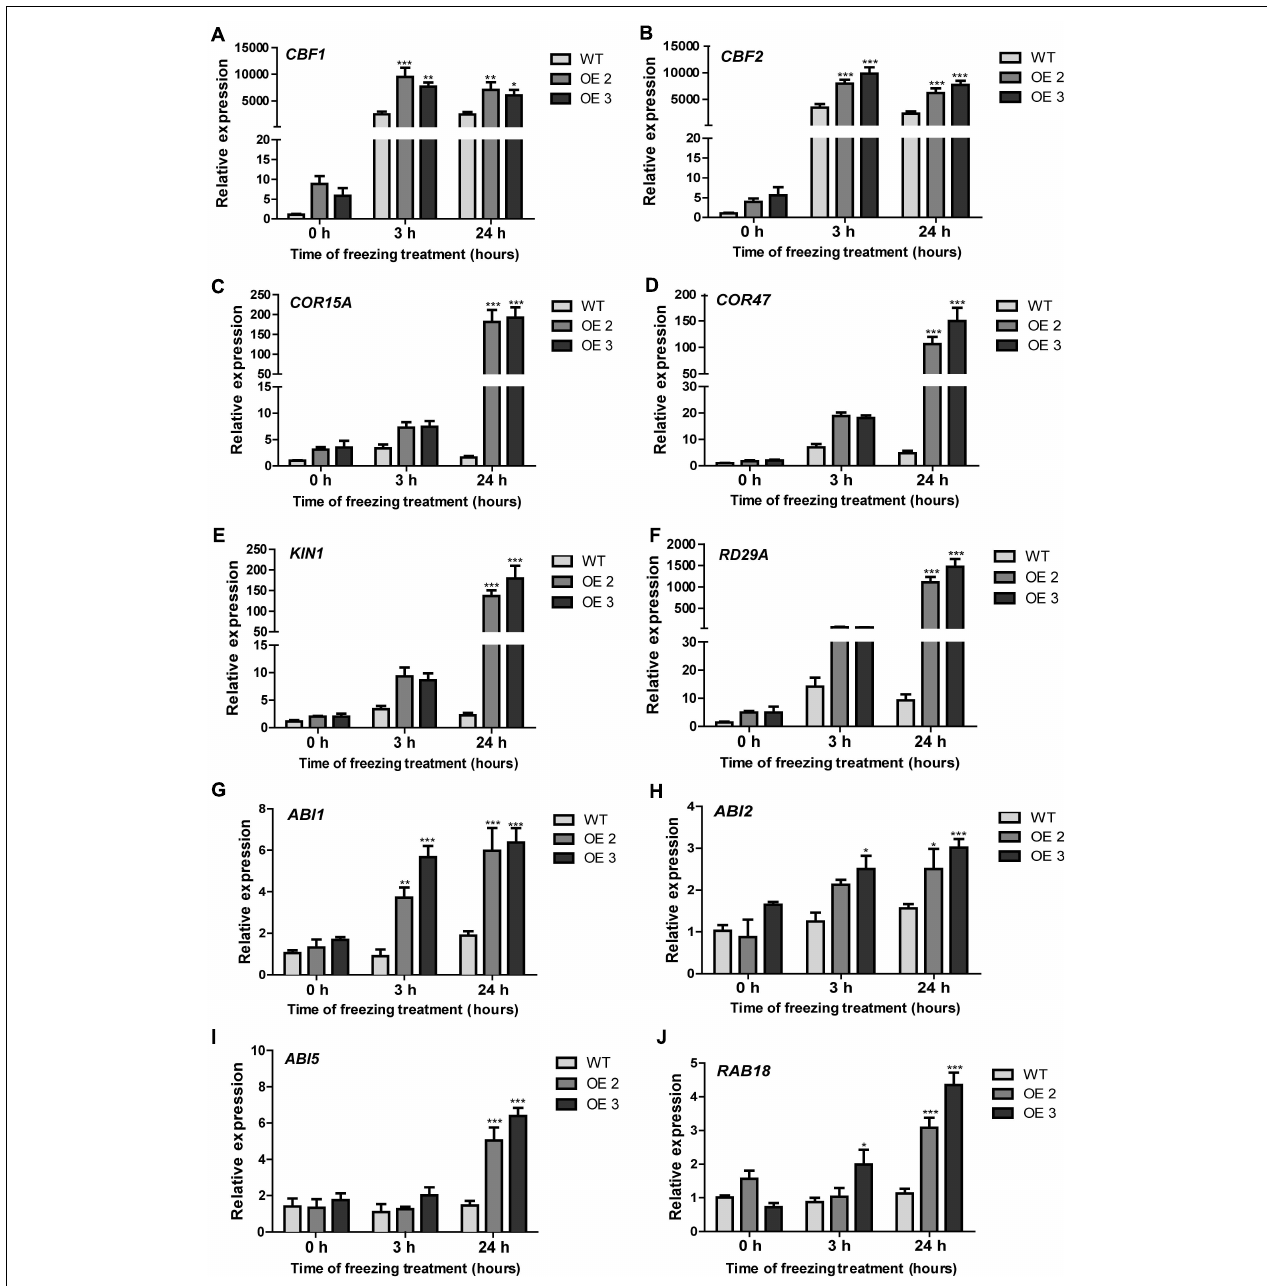
FIGURE 6 | Expression patterns of cold-responsive and ABA-associated genes in the transgenic Arabidopsis and the non-transgenic plants under freezing stress treatment. (A–F) Expression profiles of cold responsive genes, including CBF1 , CBF2 , COR15A , COR47 , KIN1 , and RD29A . (G–J) Expression profiles of ABA-related genes, including ABI1 , ABI2 , ABI5 , and RAB18 . Data represented the average of three biological replicates. Significant differences at * p < 0.05, ** p < 0.01, and *** p <